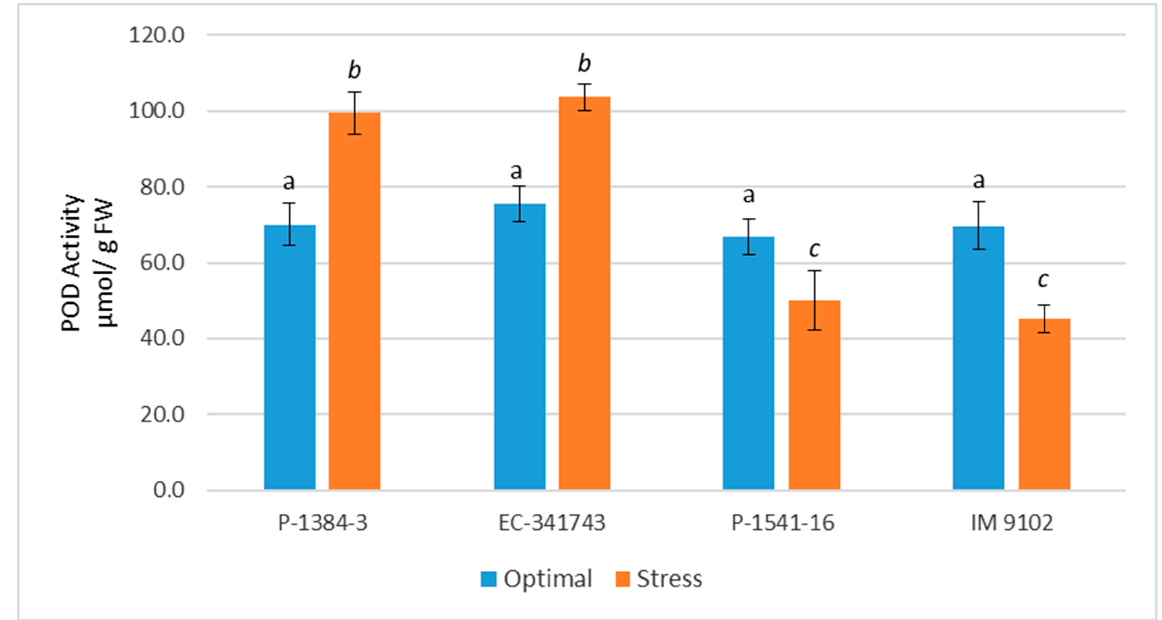
Figure 7. Peroxidase enzyme activity of four field pea genotypes under optimal and heat stress. Columns with different letters indicate significant difference at p ≤ 0.05 (Fisher LSD test).